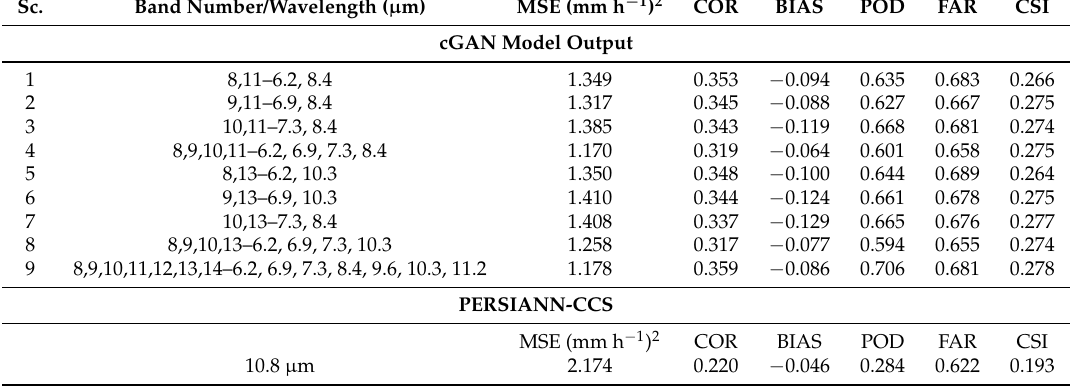
Table 6. Statistical evaluation metrics values for different scenarios using multiple spectral bands. Sc.